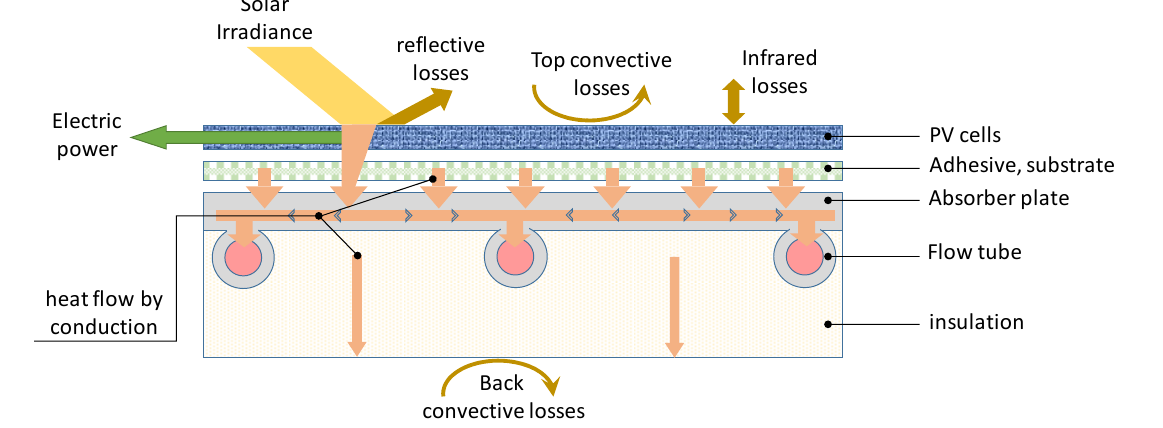
Figure 2. Cross-sectional diagram of the PV/T energy transfer process.